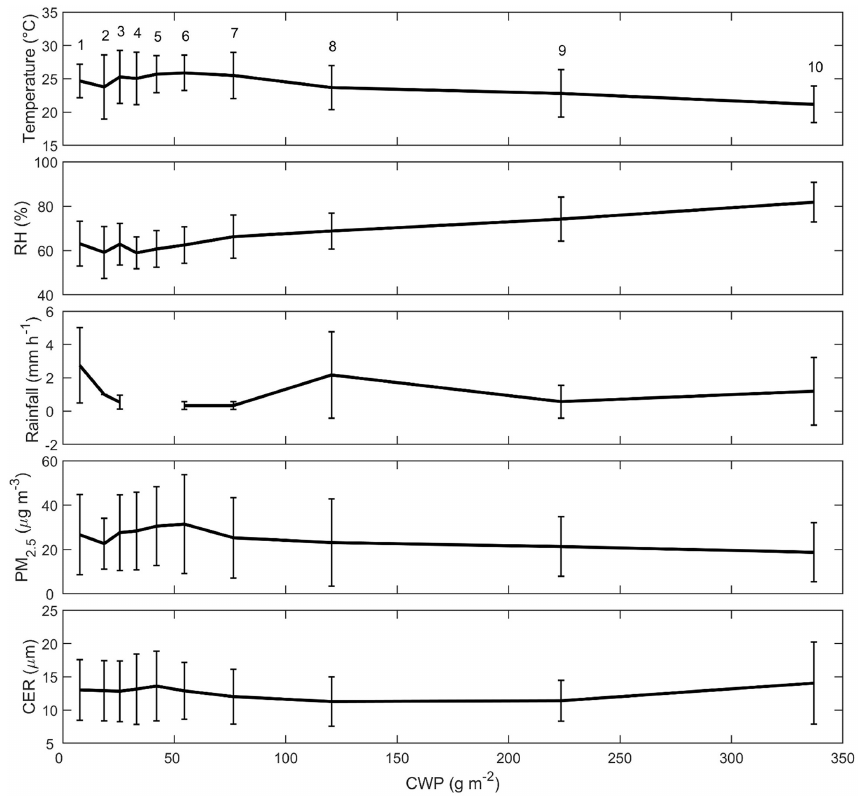
Figure 5. Multiyear (2005–2017) mean and standard deviation of temperature, relative humidity (RH), rainfall, PM 2 . 5 , and cloud effective radius (CER) in different cloud water path (CWP) bins. The CWP group numbers are marked in the top panel.